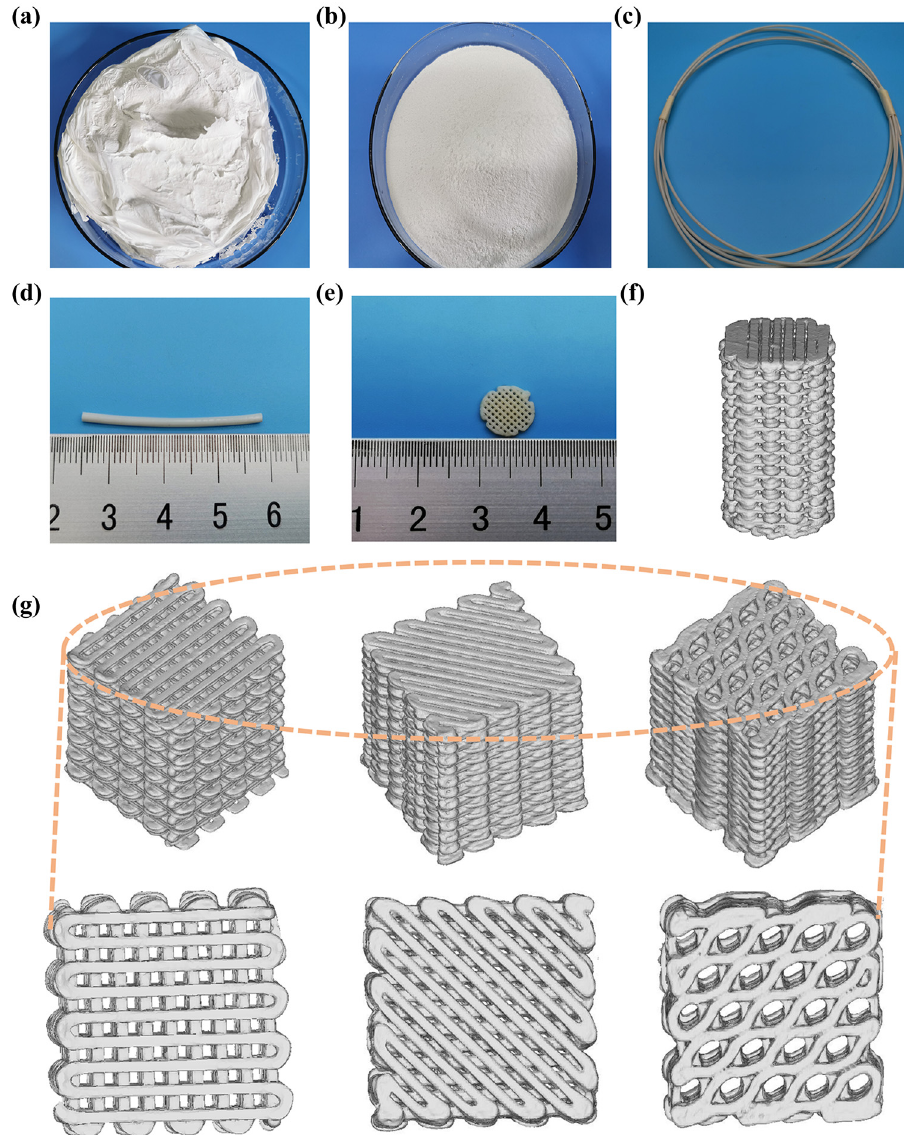
Figure 2: Manufacture of PLA/n - HA composites. ( a ) Dry raw PLA/n - HA material; ( b ) crushed raw PLA/n - HA materials; ( c and d ) PLA/n - HA composite fi lament; ( e ) 3D - printed PLA/n - HA composite cell sca ff olds; ( f ) CT reconstruction of a 3D - printed composite cylinder; and ( g ) CT reconstruction of a 3D - printed ( forward, diagonal, honeycomb )